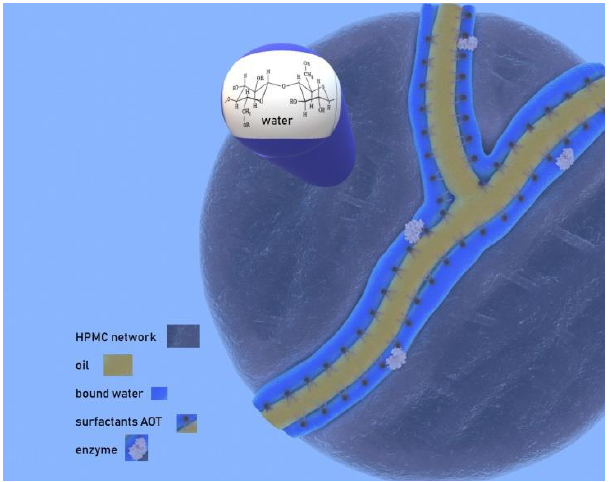
Figure 8. Proposed structural model for HPMC-based MBGs.